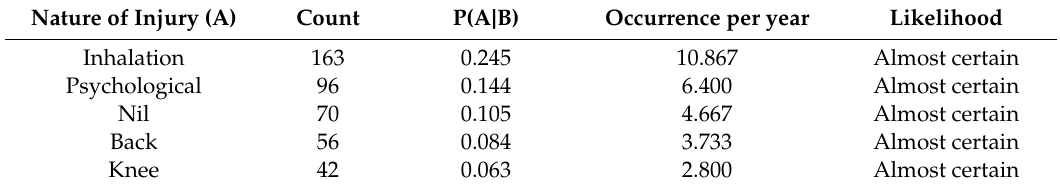
Table 3. Analysis by